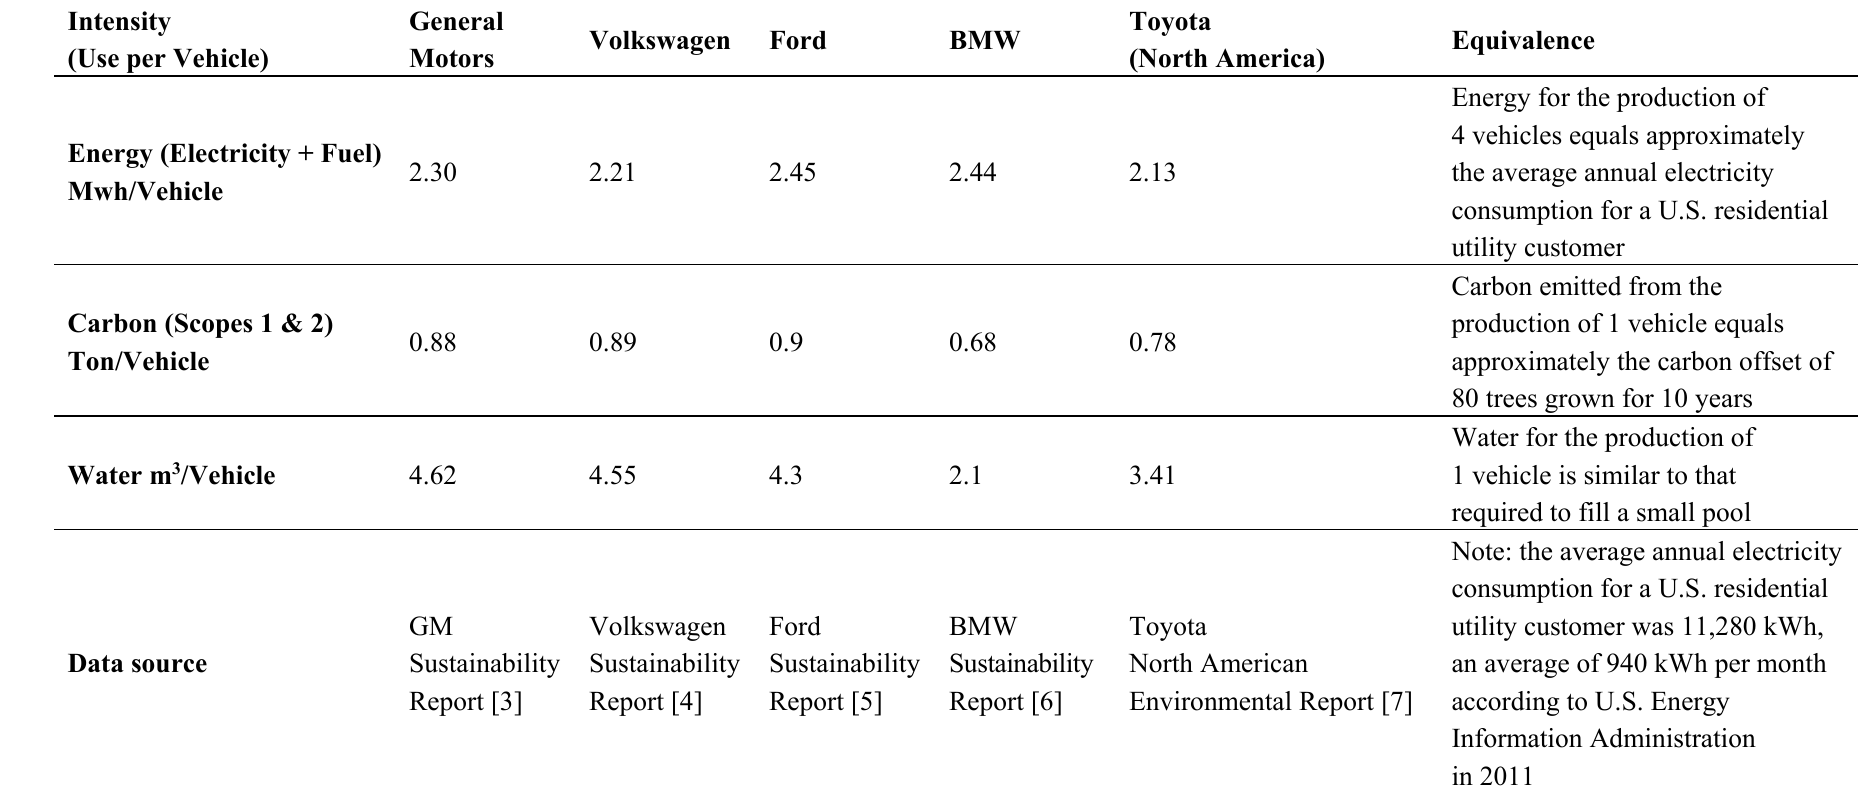
Table 1. Resources used to manufacture a vehicle